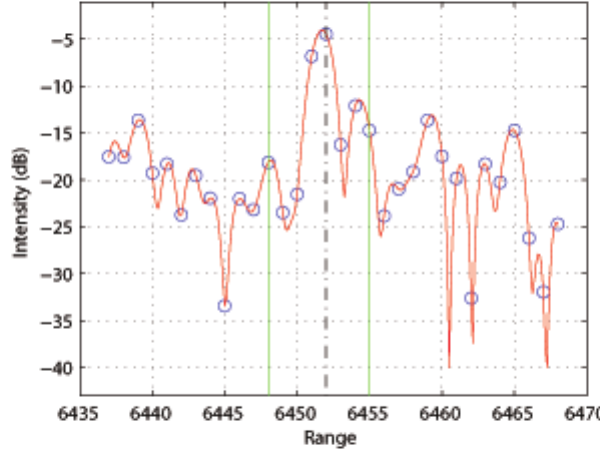
Figure 7. Corner reflector HV response (Ottawa).